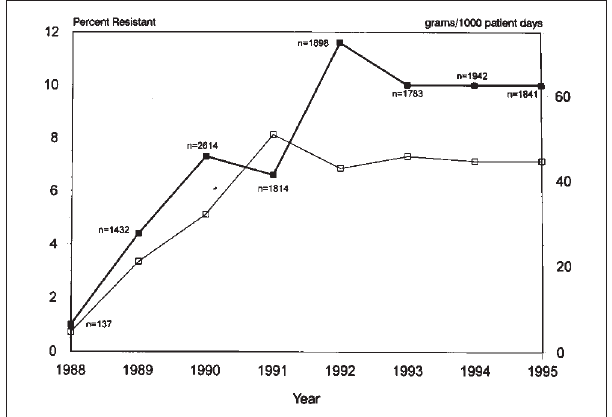
Figure 1) Relationship between ciprofloxacin use (grams per 1000 patient days) and the prevalence of ciprofloxacin-resistant Pseudomonas aeruginosa from 1987 to 1995. The number of isolates tested in each year is shown